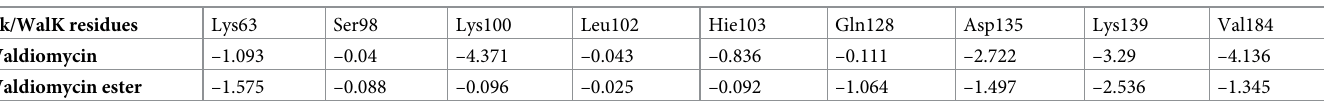
Table 1. Results of pairwise energy decomposition analysis of the high-occupancy hydrogen bonding of residues to the ligands (kcal mol -1 ). Hk/WalK